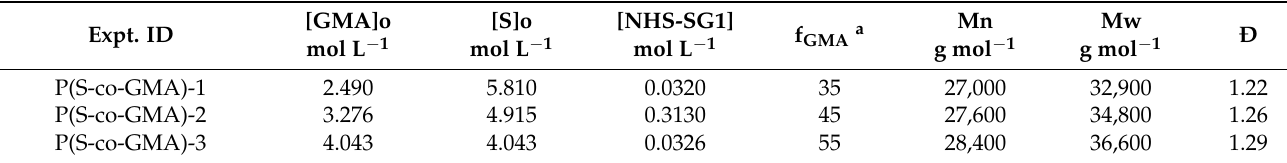
Table 1. Experimental conditions for the synthesis of P(S-co-GMA) copolymers at T = 105 ◦ C using N-hydroxysuccinimidyl- functionalized SG1 (NHS-SG1) as NMP controller. Expt.